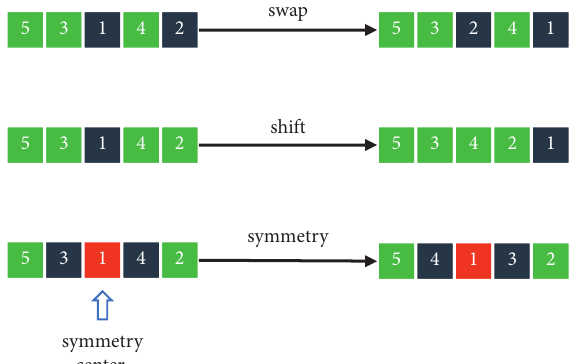
Figure 6: Sketch of swap operation, shift operation, and symmetry operation. The length of subsequences in this figure is